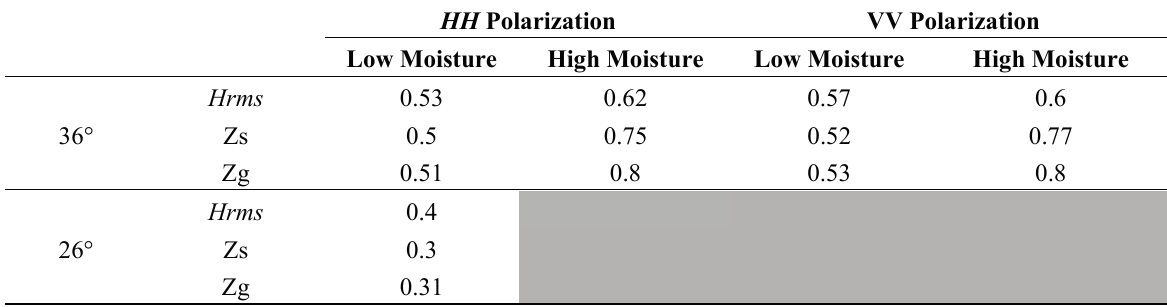
Table 2. Correlation coefficients retrieved from logarithmic regressions, for various roughness parameters and multi-configuration radar